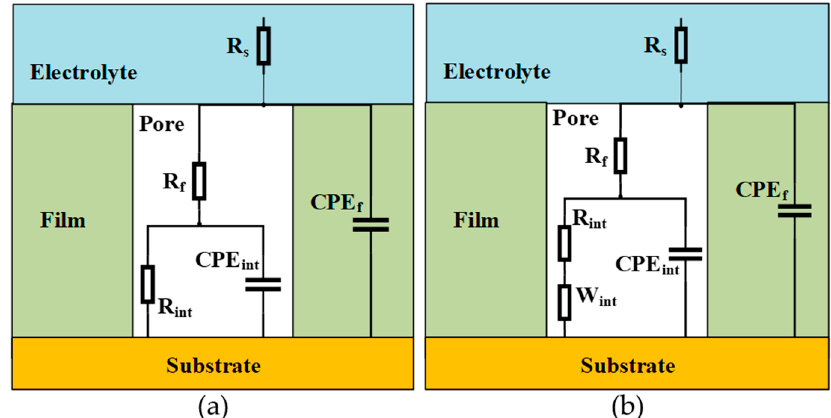
Figure 1. Equivalent electrical circuit used to fit impedance spectra measured in ( a ) deoxygenated and ( b ) oxygenated electrolyte. R s is the solution (electrolyte) resistance, R f is the film (or pore) resistance, CPE f is the constant phase element representing film capacitance, CPE int is the constant phase element representing interfacial capacitance (metal-solution interface), R int is the interfacial resistance, and W int is the interfacial Warburg diffusion element.